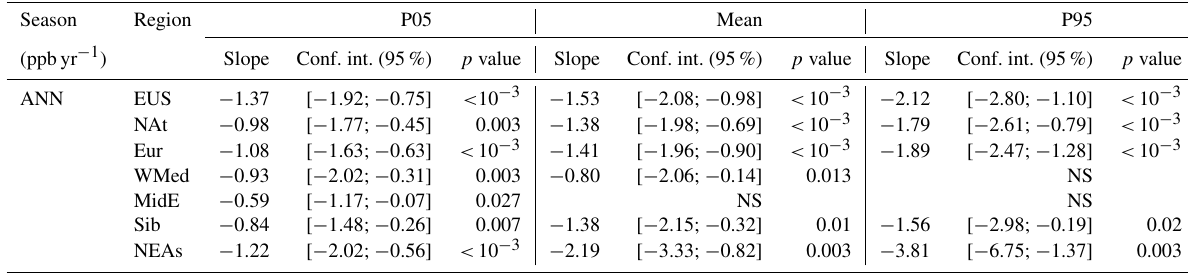
Table D5. CO absolute trends in ppbyr − 1 during all the year in the UT. From left to right, the anomalies are taken from deseasonalized P05, monthly means, and P95. The insignificant trends with respect to the 95% confidence level are indicated as NS.